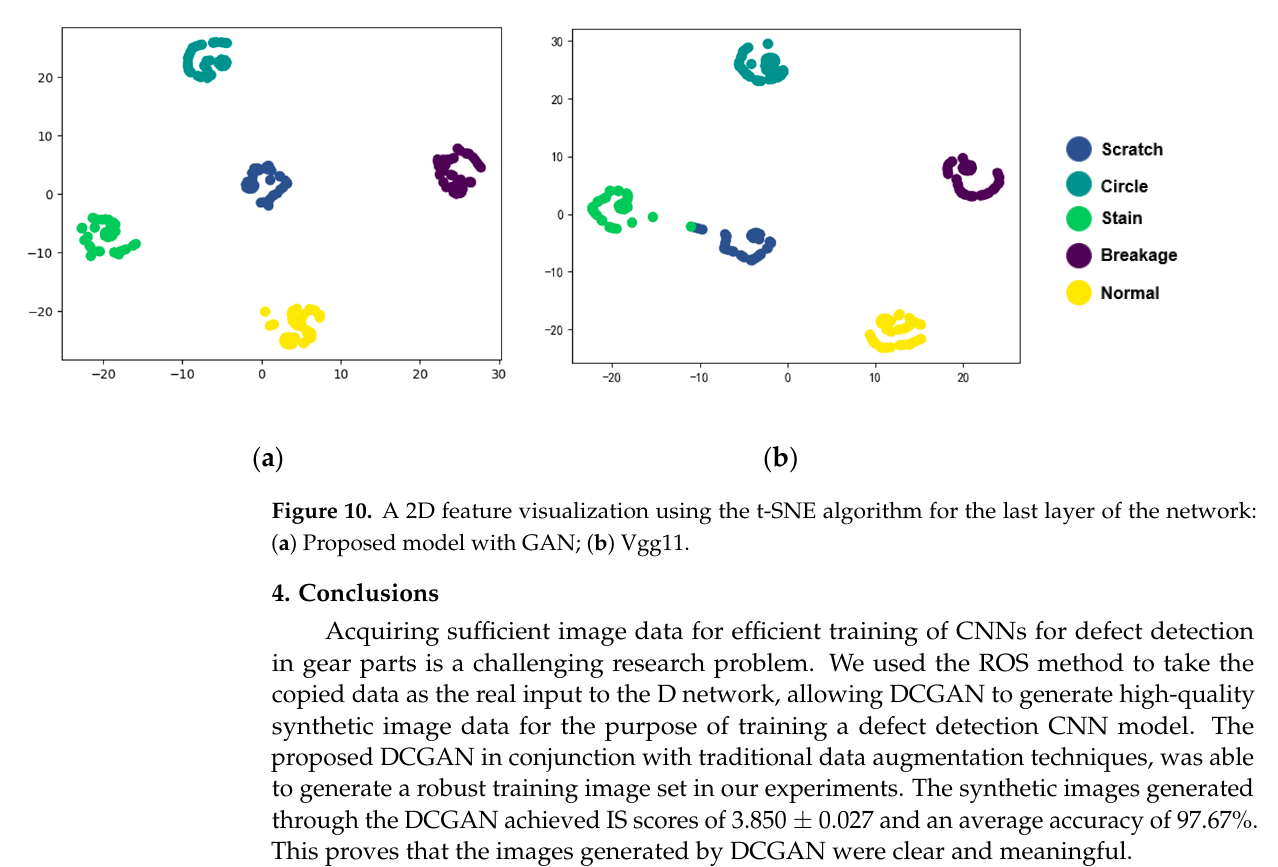
Proposed model with GAN; ( b ) Vgg11. ( a )